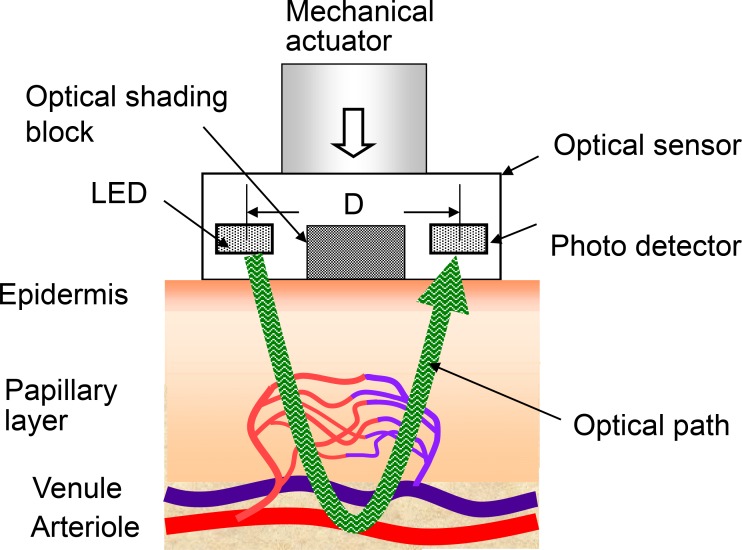
Schematic diagram of an optical sensor with a pressurization mechanism.